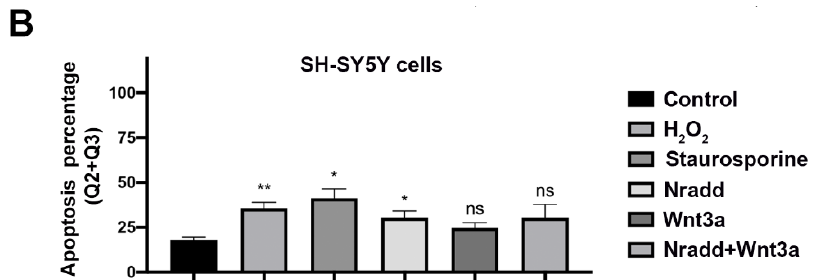
Figure 7. Zebrafish Nradd enhances apoptosis in neuroblastoma cells. ( A ) Apoptosis assay on SH-SY5Y cells using flow cytometry after staining with annexin V-FITC and 7AAD. Representative scatter plots of 7AAD (y-axis) vs. annexin V-FITC (x-axis). Nradd significantly induces apoptosis. ( B ) Percentage of apoptotic cells, * indicates p < 0.05, ** is p < 0.01 and ns is non-significant. All experiments were performed in five replicates. Three independent experiments were con- ducted.